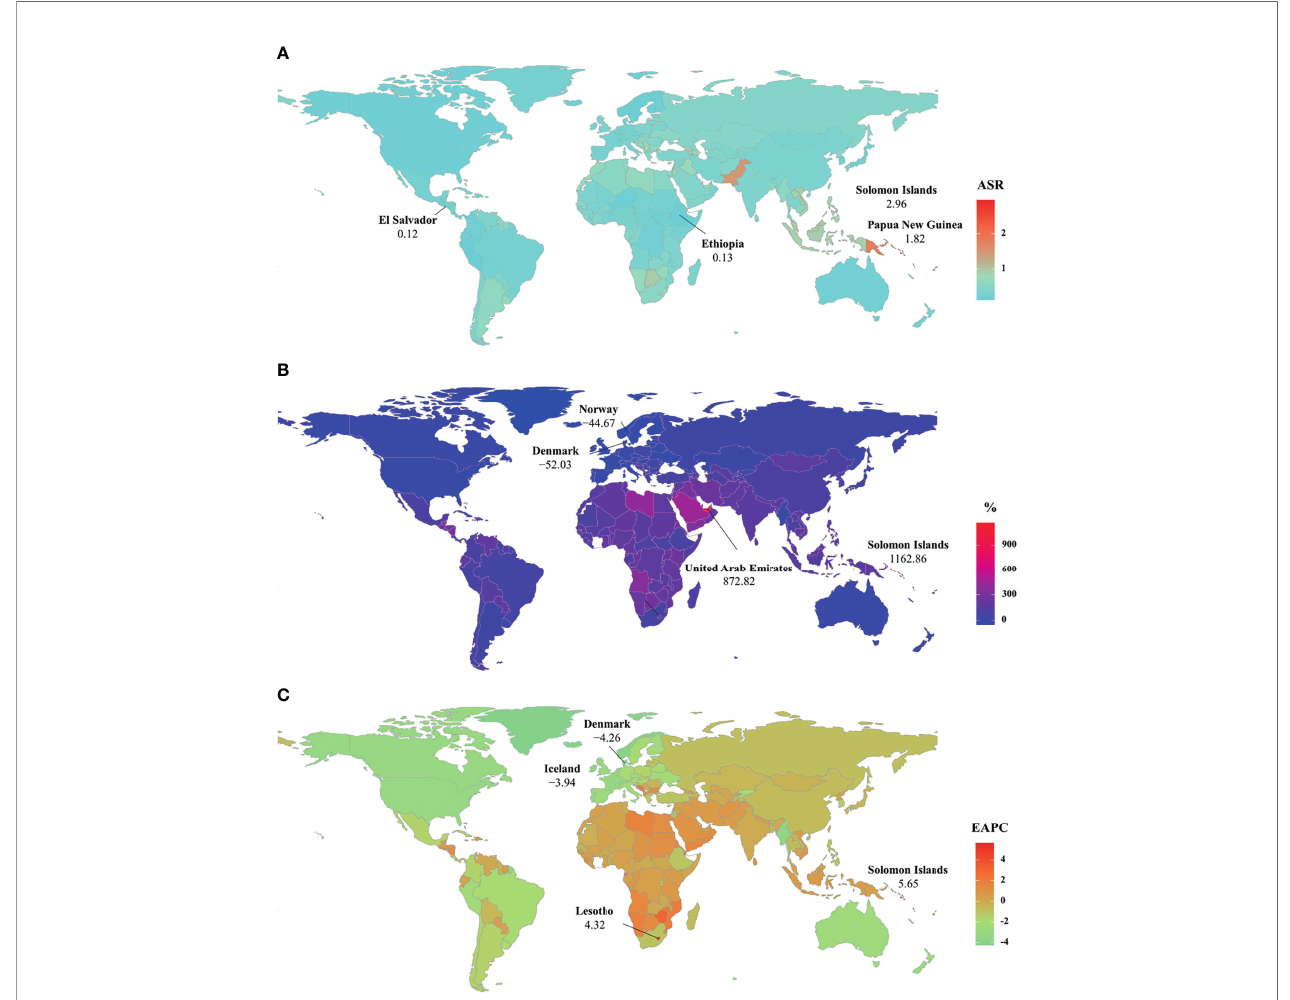
FIGURE 3 | The distribution of ASRs, percentages, and EAPCs of death caused by breast cancer attributable to secondhand smoke at the national level. (A) was the ASDR in 2019; (B) was the percentage changes in death number between 2000 and 2019; (C) was the EAPCs of death, respectively. Countries/territories with an extreme value were annotated. ASDR, age-standardized death rate; EAPC, estimated annual percentage